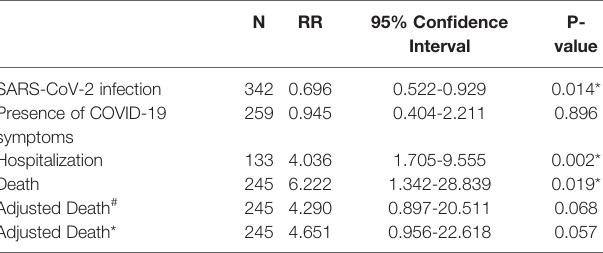
TABLE 3 | Risk of the MERS-exposed group relative to SARS-CoV-2 infection, symptom presence, hospitalization and death.